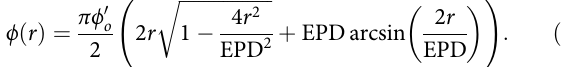
Figure 2d plots the fi nal phase shift verses position for each